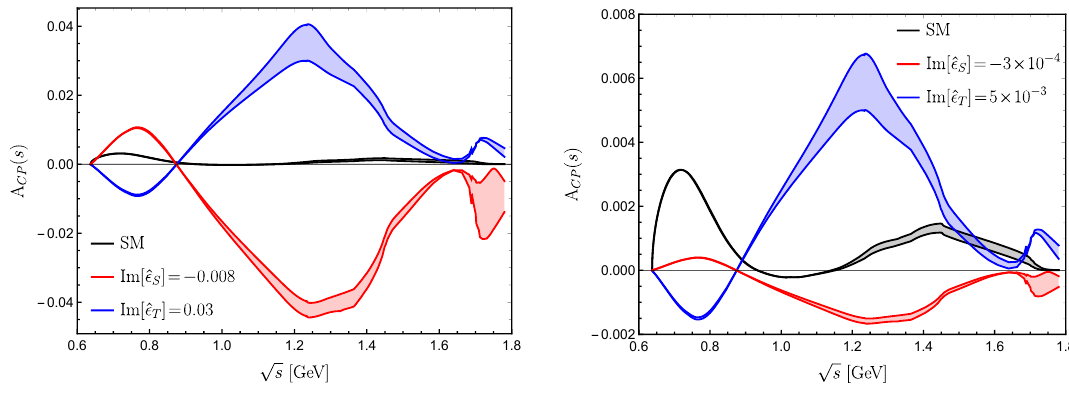
Figure 3 . Left: distributions of the CP asymmetries in the whole Kπ invariant-mass region for three different cases, the SM prediction (gray band), the non-standard scalar contribution with Im[ˆ (cid:15) S ] = − 0 . 008 (red band), and the non-standard tensor contribution with Im[ˆ (cid:15) T ] = 0 . 03 (blue band). Right: the zoomed-in version of the SM prediction as well as the cases with Im[ˆ (cid:15) S ] = − 3 × 10 − 4 (red band) and Im[ˆ (cid:15) T ] = 5 × 10 − 3 (blue